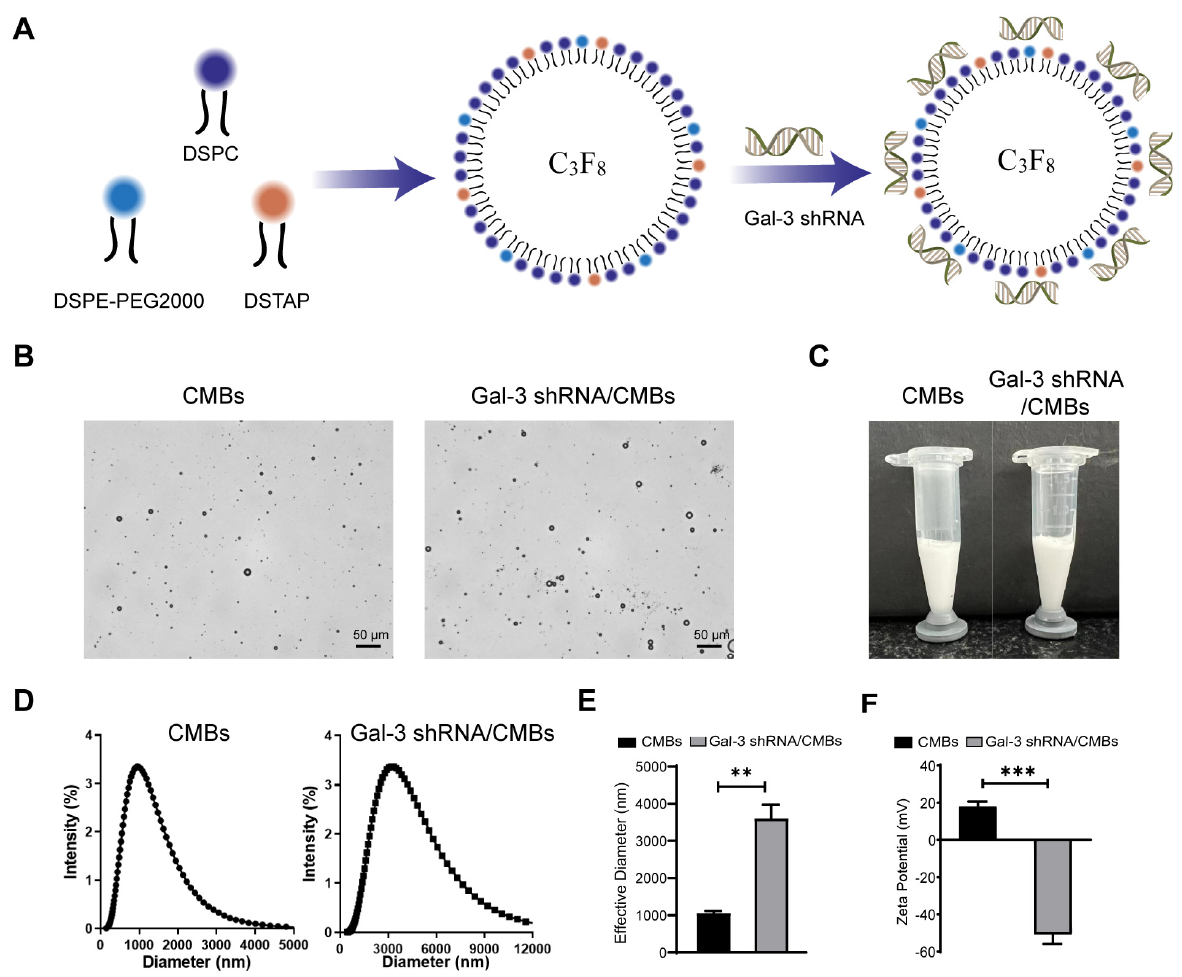
Figure 2. Characterization of Gal-3 shRNA/CMBs. ( A ) Schematic representation of Gal-3 shRNA/CMBs preparation. ( B ) Representative optical micrographs of CMBs and Gal-3 shRNA/CMBs. ( C ) Appearance of the CMBs and Gal-3 shRNA/CMBs. ( D ) Size distribution of CMBs and Gal-3 shRNA/CMBs. ( E ) Average particle size of CMBs and Gal-3 shRNA/CMBs. ( F ) Average Zeta potentials of CMBs and Gal-3 shRNA/CMBs. ( n = 3, ** p < 0.01 *** p < 0.001).